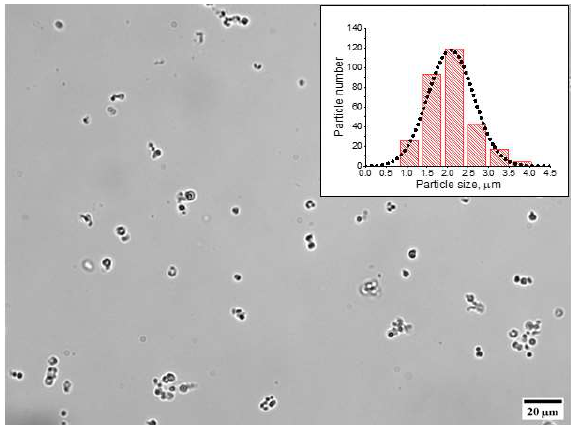
Figure 2. Microphotograph of typical polyelectrolyte microcapsules obtained by optical microscopy. The size distribution histogram of the prepared microcapsules is shown in the inset.